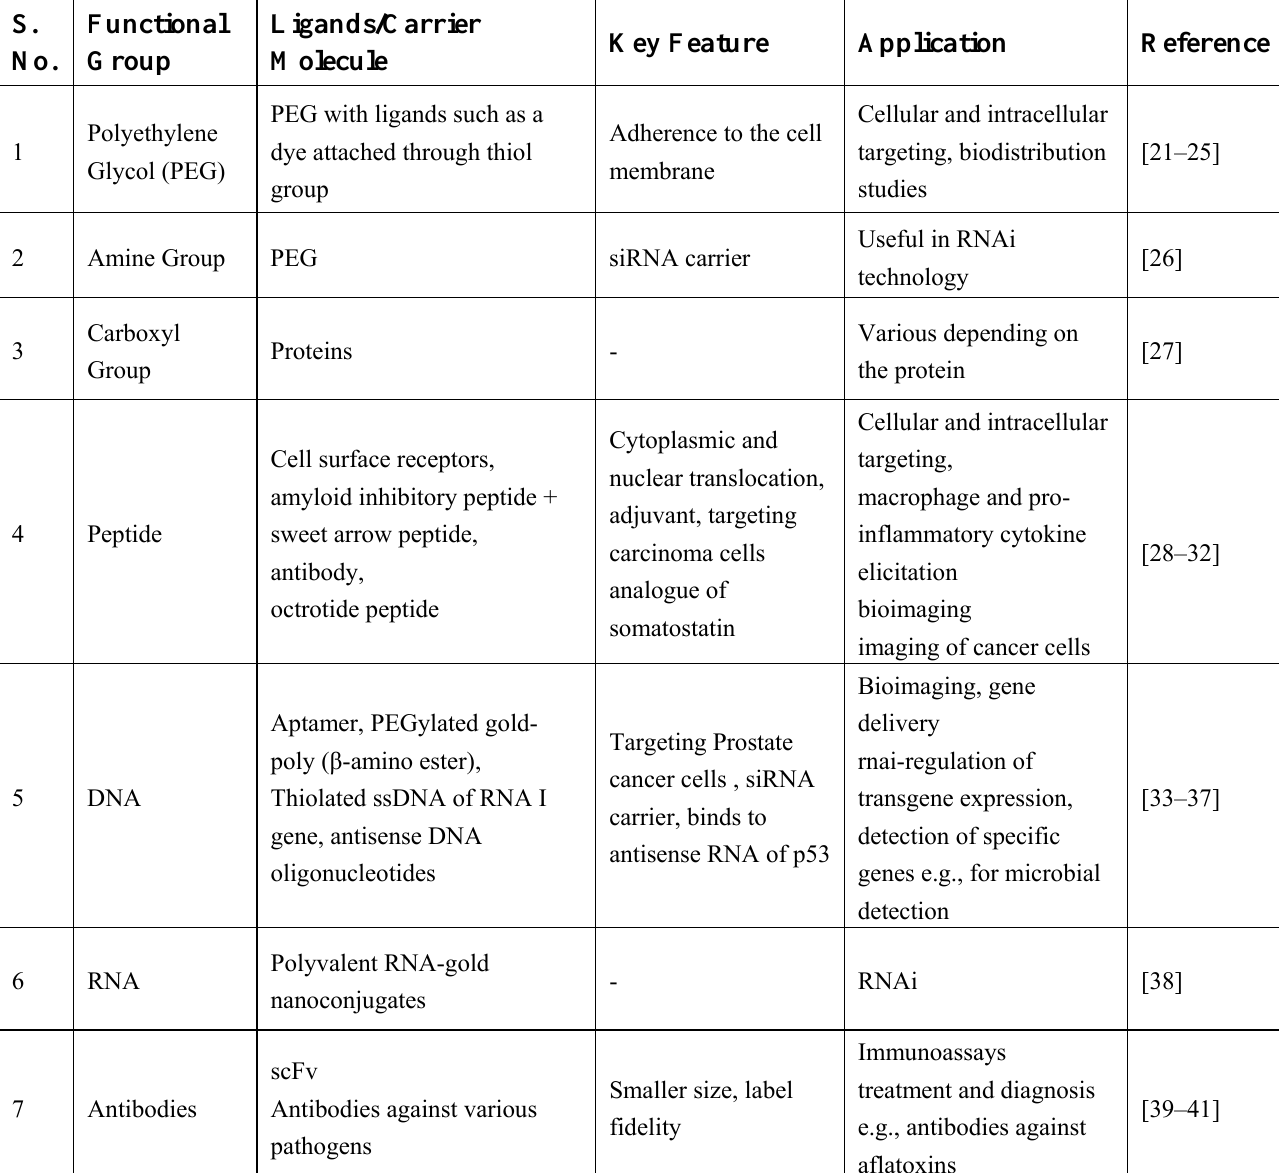
Table 1. Summary of common functionalization methods and their applications.